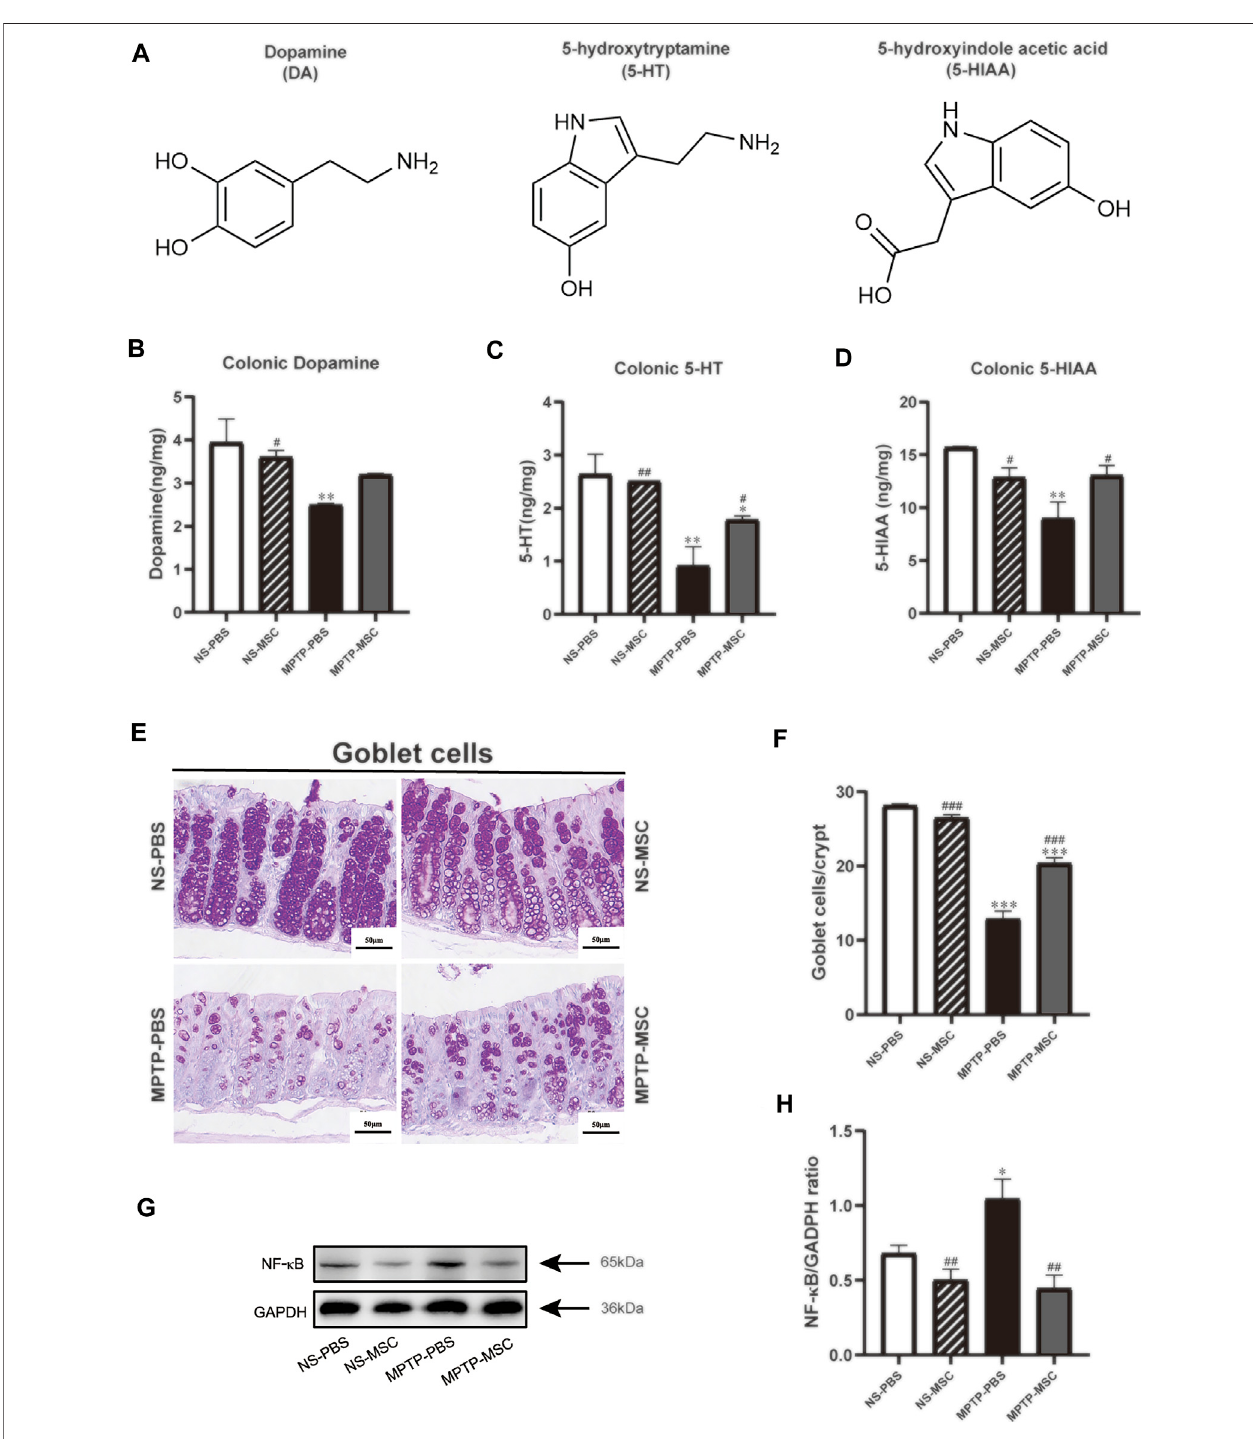
FIGURE7| Effects ofUC-MSCtreatmentontheneurotransmitters,gobletcells, and theexpression ofNF- l Bin thecolonofMPTP-treatedPDmice. (A) Chemical structuresoftheneurotransmitters; (B – D) DA,5-HT,and5-HIAAwereanalyzedbyHPLC; (E) PASstainingofthecolon(scalebar,50 μ m); (F) gobletcells/cryptofcolon; (G , H) Western blot and quantitation of NF- l B protein expression in the colon. Data of (A – H) ( n (cid:1) 3 per group) are expressed as mean ± SE. * p < 0.05, ** p < 0.01, *** p < 0.001 compared with the NS-PBS group, # p < 0.05, ## p < 0.01, ### p < 0.001 compared with the MPTP-PBS group by one-way ANOVA.